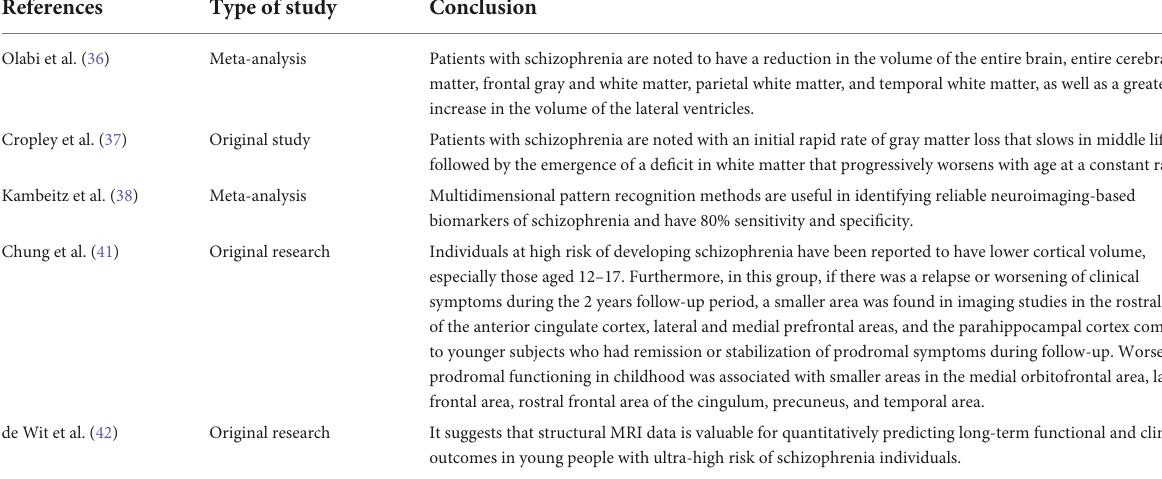
TABLE 3 Studies on the potential use of neuroimaging markers in schizophrenia.